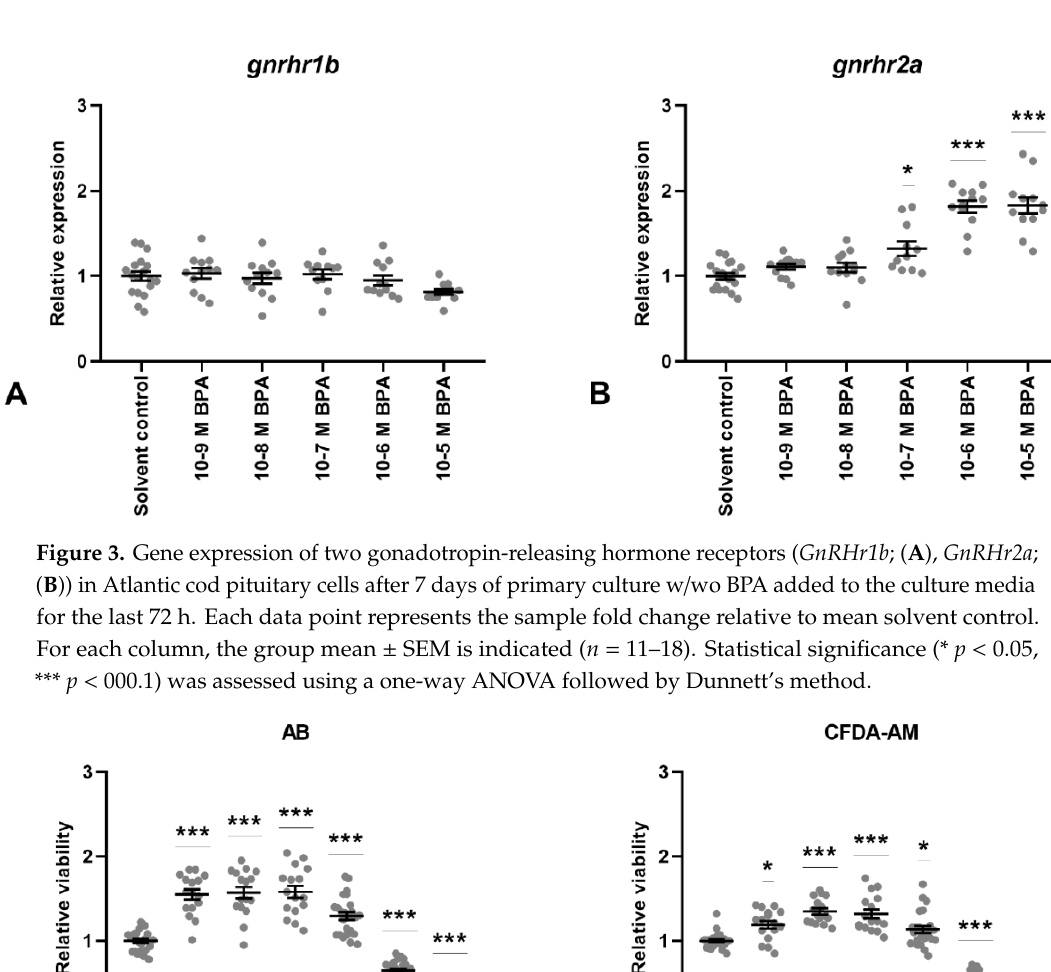
Figure 2. Gene expression of gonadotropin subunits ( FSHb ; ( A ), LHb ; ( B )) in Atlantic cod pituitary cells after 7 days of primary culture w/wo BPA added to the culture media for the last 72 h. Each data point represents the sample fold change relative to mean solvent control. For each column, the group mean ± SEM is indicated ( n = 11 – 18). No statistical differences between groups were detected (tested by Kruskal – Wallis; (A) , or one-way ANOVA; (B) ).